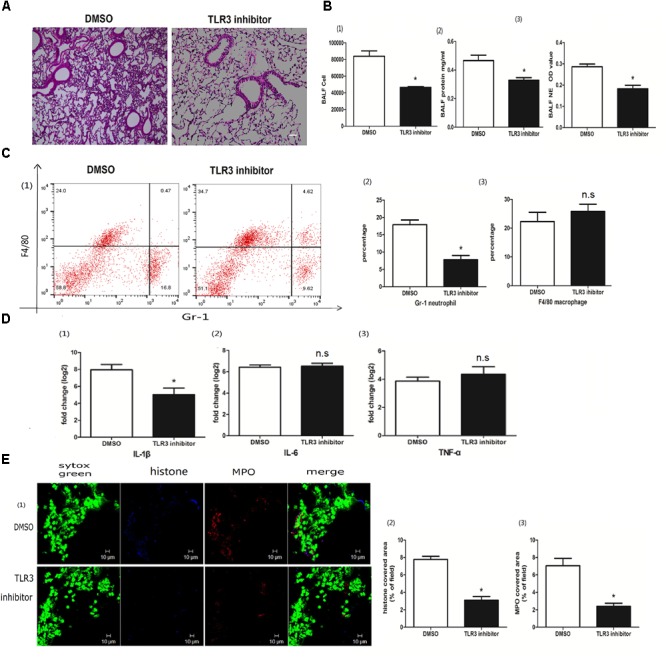
The role of poly I:C-induced NETs in ALI was TLR3 dependent. (A) Infiltration of inflammatory cells and interstitial edema in the lung lobe were reduced in the ALI mice treated with the TLR3 inhibitor, bar = 100 μm; (B-1) cells were counted in the BALF, ∗p < 0.05; (B-2) protein concentration in the BALF, ∗p < 0.05; (B-3) neutrophil elastase (NE) activity was evaluated in the BALF, ∗p < 0.05; (C) flow cytometry analysis of the BALF cells, ∗p < 0.05; (D) inflammatory cytokines IL-1β, IL-6, and TNF-α in the lung were quantified using qRT-PCR, ∗p < 0.05; (E) NETs were observed and quantified in lung tissues from mice administered poly I:C and a TLR3 inhibitor.